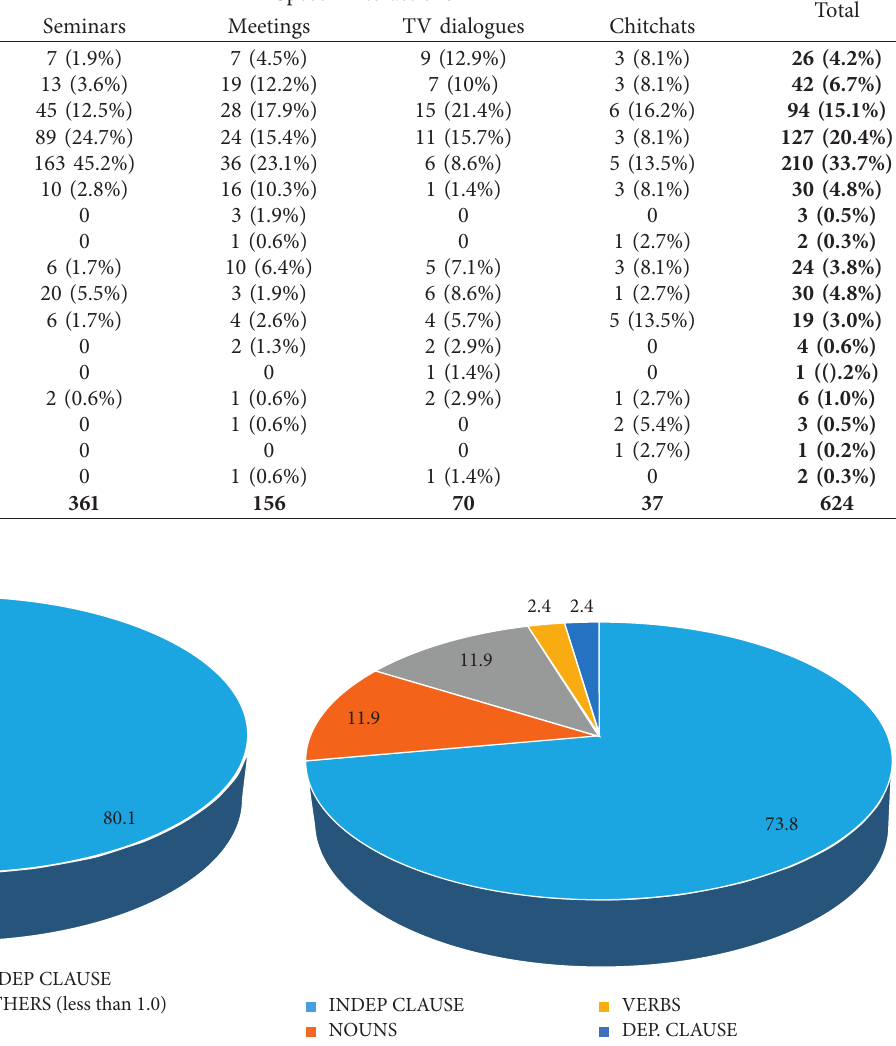
Figure 1: The dominant switched segments of IECS. Table 2: The switched segments of English-Indonesian code- switching.